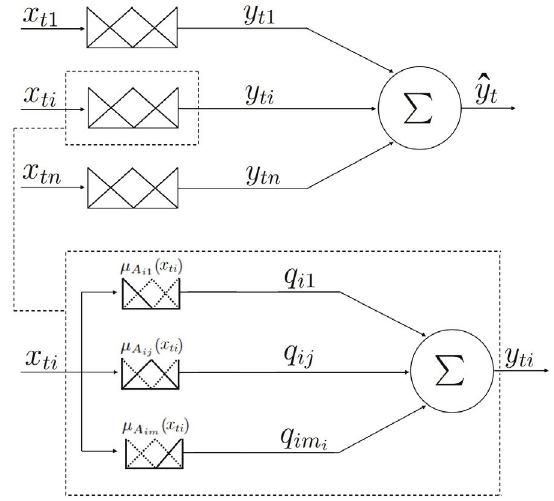
Figure 1. Structure of the X-eNFN-AFS neural.